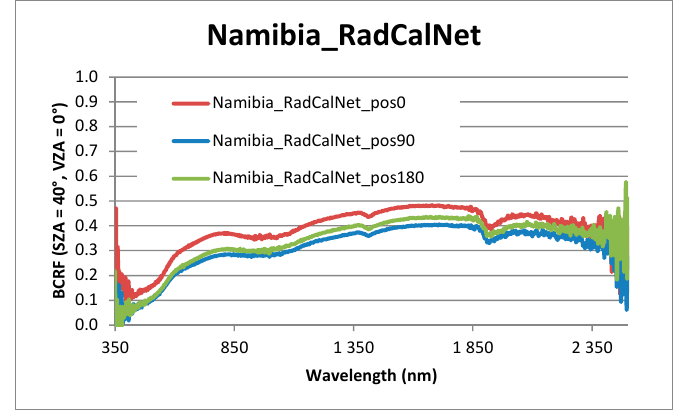
Figure 4. Spectral variation of BCRF for the Namibia_RadCalNet sample for the three positions .